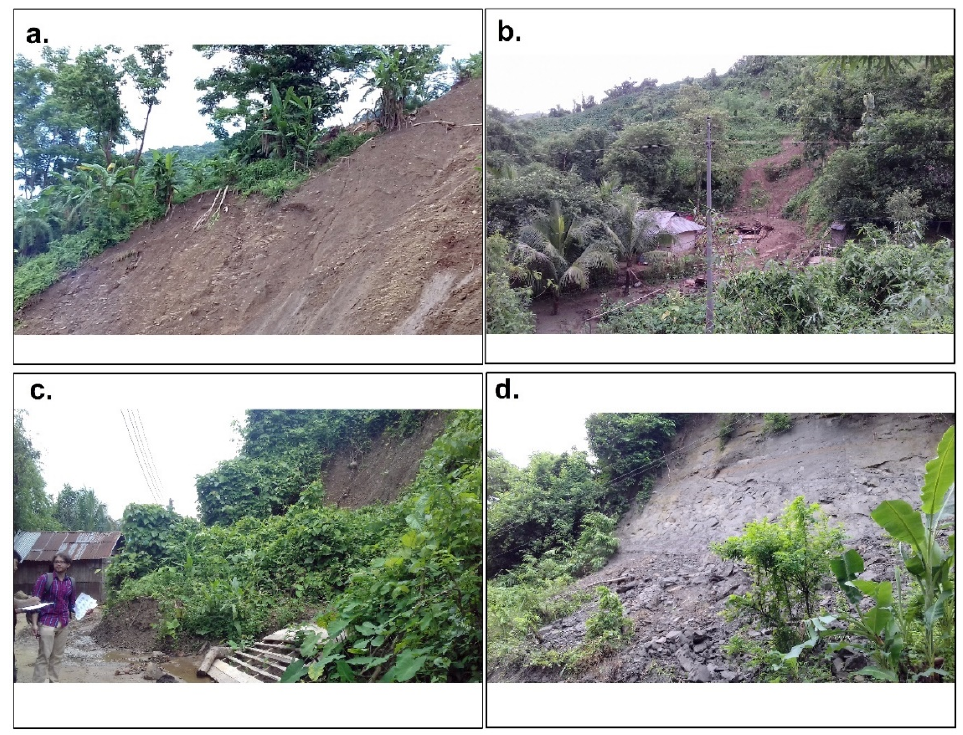
Figure 2. ( a ) Landslides damaged plantation agriculture in Bandarban; ( b ) Landslides damaged bamboo-made house in Rangamati; ( c ) Field work in Rangamati; ( d ) Landslides along the road in Chittagong.